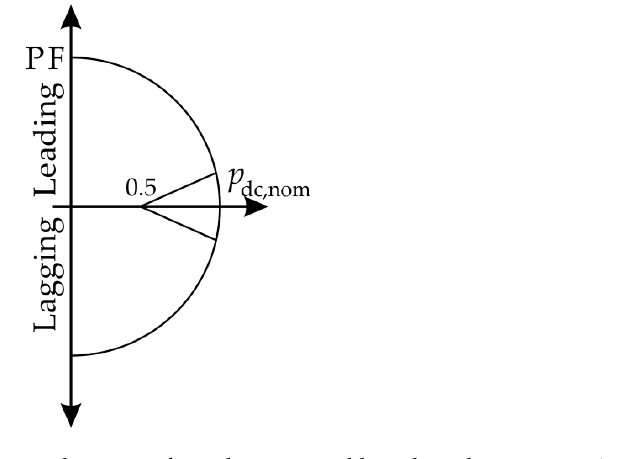
Figure 2. Variable power factor control strategy for voltage control based on the power ratings of the